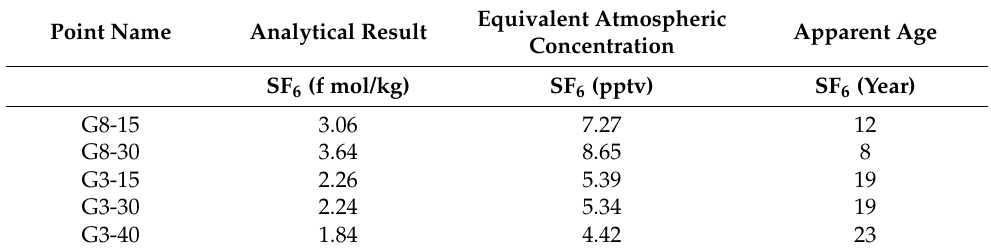
Table 1. Average apparent age of groundwater with different depths by SF 6 .